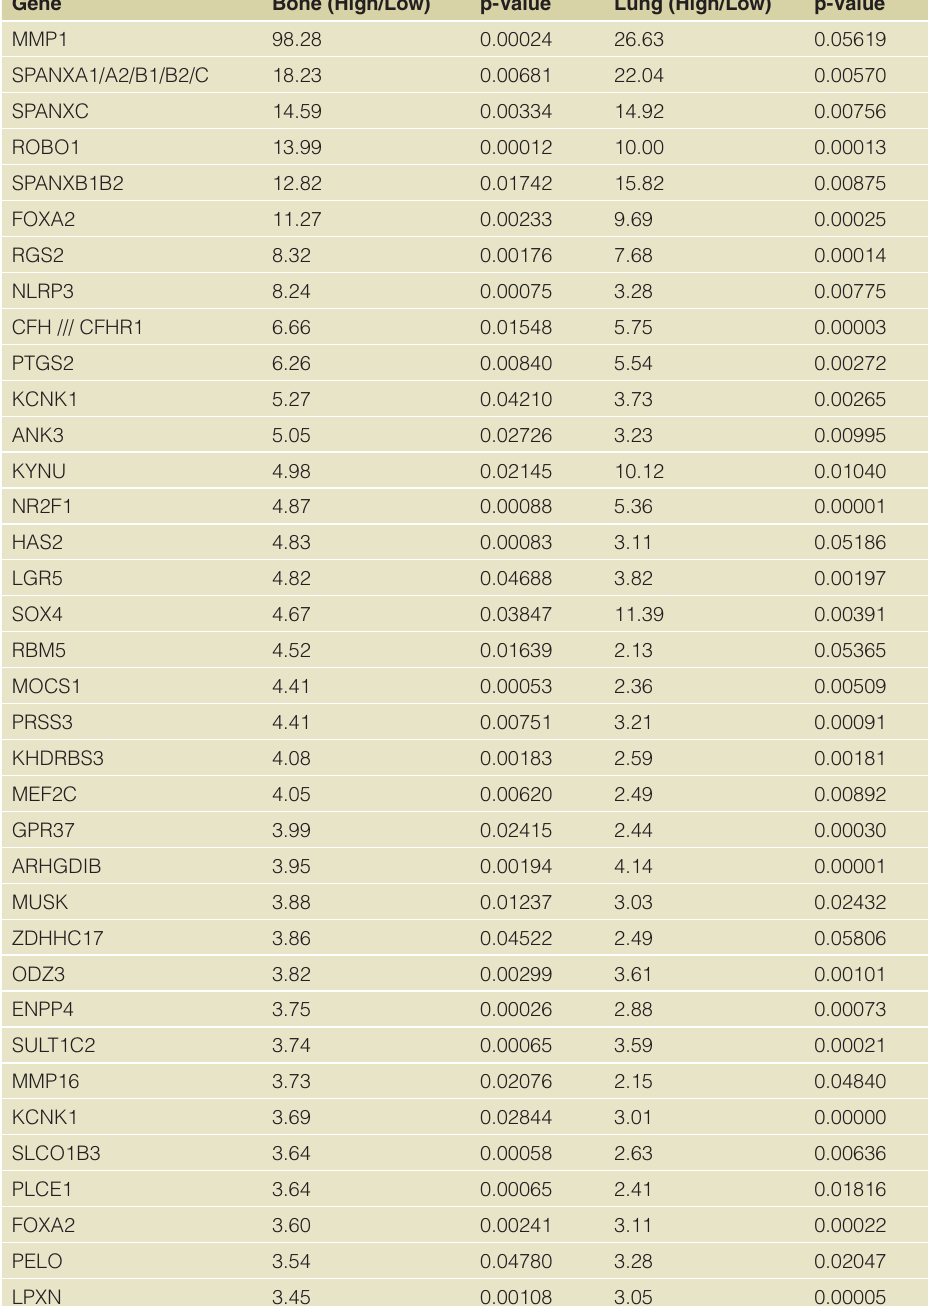
Supplemental Table S1. Top genes with greatest expression differential in genes of high metastatic potential and low metastatic potential in bone and lung. High bone metastatic cell lines are: 1833, Scp-2, Scp-25 and Scp-46. High lung metastatic cell lines are: 1834, 3481, 4142, 4173, 4175, 4180, Scp-3 and Scp-28. Low metastatic cells lines are: MDA-MB-231, Scp-6, Scp-21 and Scp-26. The gene expression values for these cell lines (Minn et al. , 2005) were used in a two-tailed t-test to calculate relative p-values. Genes with over three fold greater expression in bone lines and two fold in lung lines with p-values less than 0.06 are